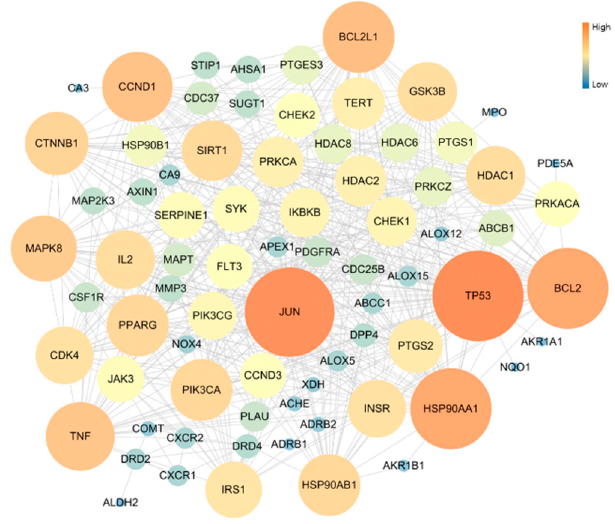
Figure 3. Topology analysis of PPI related COPD disease: the higher degree genes are expressed as large circles and in orange color.